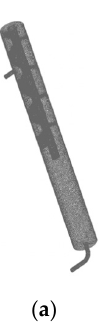
Figure 5. Meshing diagram of discrete pipes. ( a ) Mesh division of the spiral orbit, with an encrypted mesh of 89,900; ( b ) mesh division of the semicircular baffle, with an encrypted mesh of 72,000; ( c ) mesh division of the four-hole plate, with an encrypted mesh of 62,700; and ( d ) mesh division of the seven-hole plate, with an encrypted mesh of 66,300.